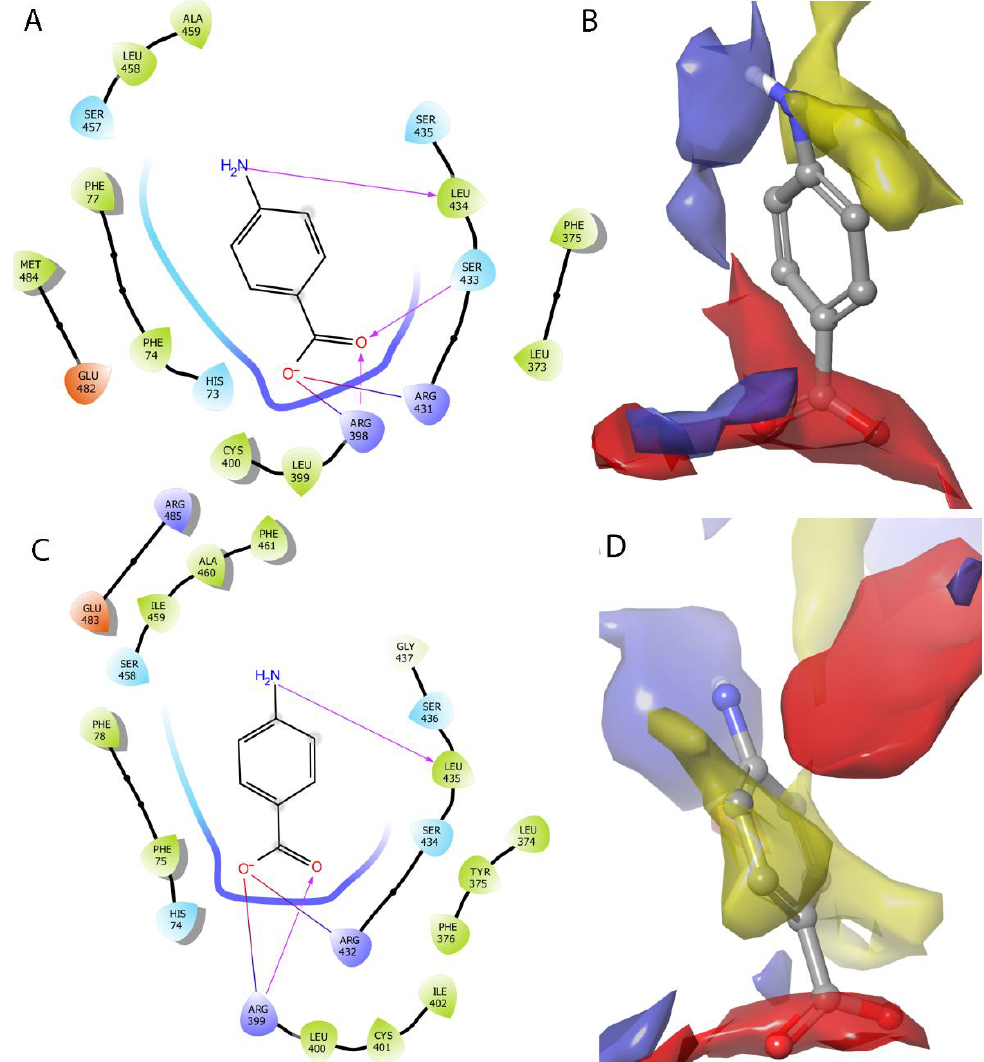
Figure 8. Binding model of HEA- p ABA in the auxin-binding site of CsTIR1 ( A , B ) and SlTIR1 ( C , D ). The blue surface is favorable for occupancy by functional groups that act as hydrogen bond donors, the red surface for hydrogen bond acceptor groups and the yellow areas can easily accommodate hydrophobic parts of a potential ligand.